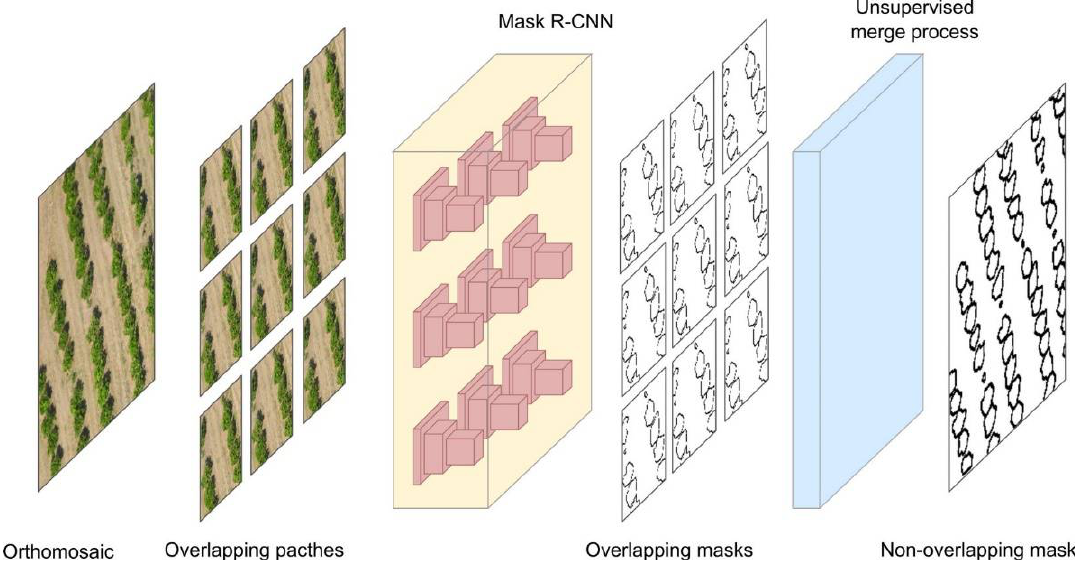
Figure 6. Framework (from left to right) adopted in process of canopy identification and result mosaicking.